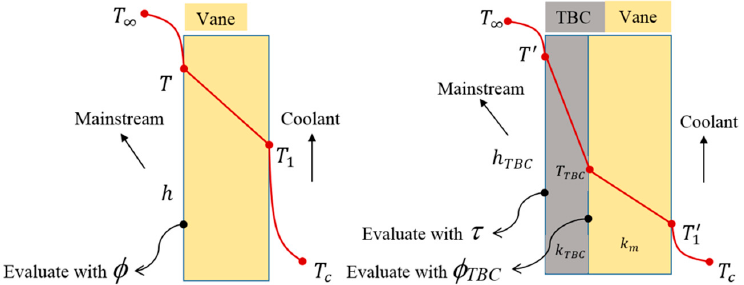
Figure 1. Evaluation thermal parameters on vane surface with and without thermal barrier coating.